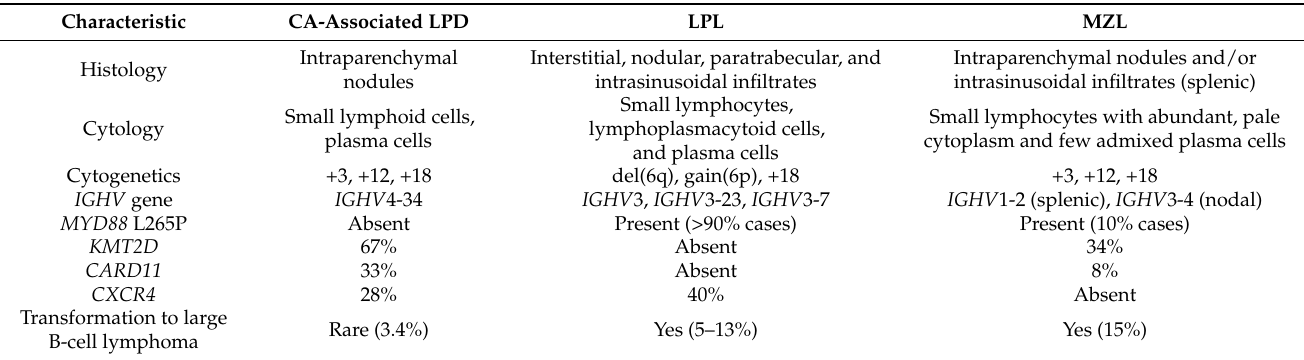
Table 2. Differential diagnosis of CA-associated LPD, lymphoplasmacytic lymphoma (LPL), and marginal zone lymphoma